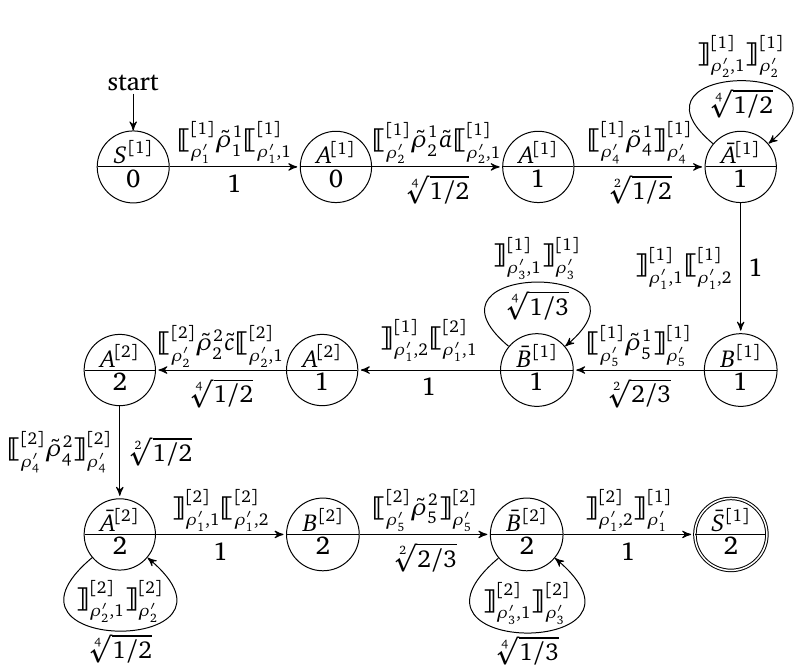
Figure 8: Product of M ′ ( G B ) and M h , w with the weight assigned by wt G , ⊴ to words read in each transition